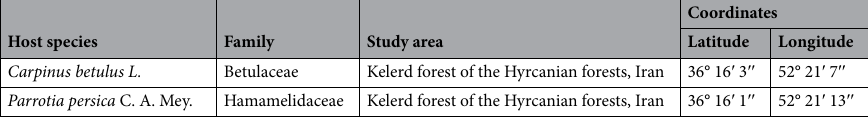
Table 3. Host species of V. album and their location.